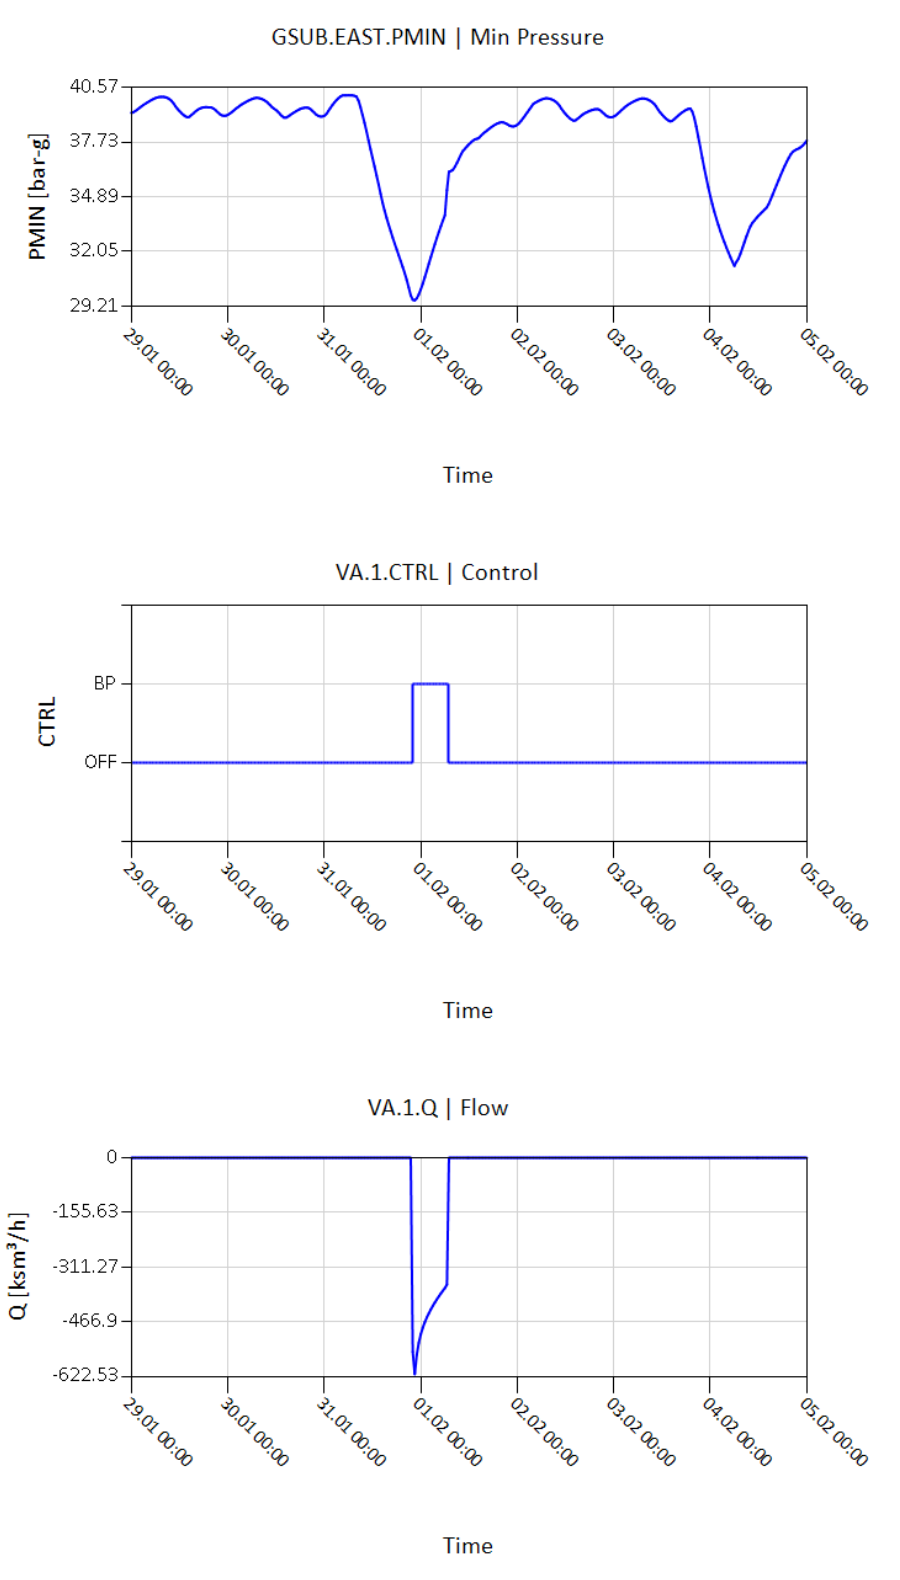
Figure 13. Time evolution of minimum pressure in subsystem GSUB.EAST and control mode and flow rate at valve station VA.1 for DA simulation for Q1 and for a 20% wind and solar